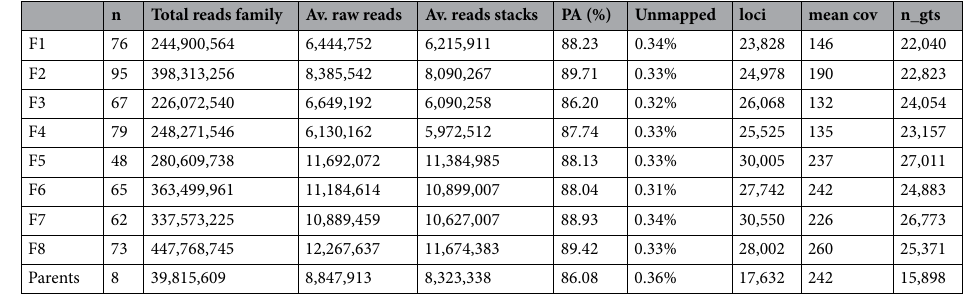
Table 3. Main statistics of ddRAD libraries, mapping and SNP detection. The total number of individuals analysed (n), the total reads per family, the average number of paired-end reads per individual, the average number reads used by stacks, the % of primary alignment and unmapped reads, number of loci , effective coverage, and number of genotypes (n_gts).